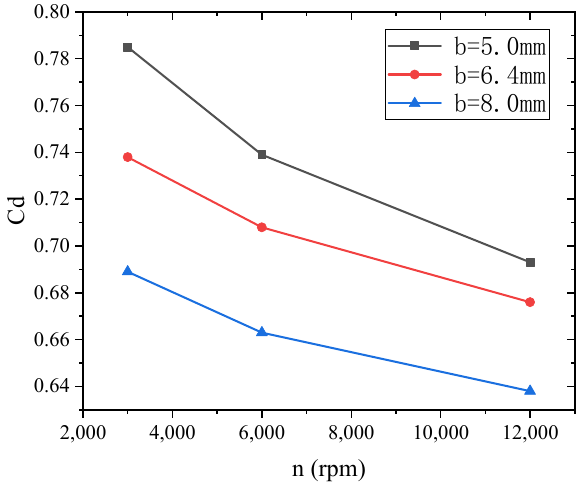
Figure 11. Rotating speed–leakage characteristics curve at different pitch.